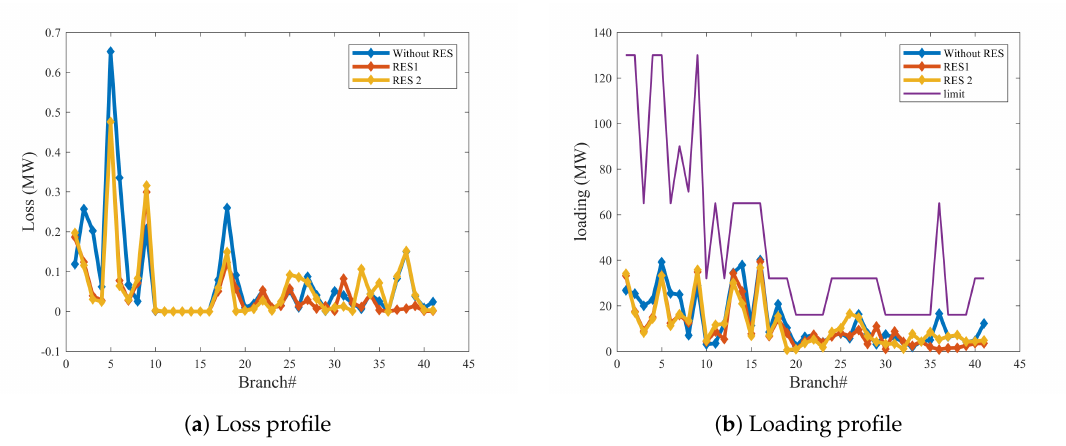
Figure 6. Loss and Loading Profiles for case 1 for IEEE 30-bus system, IEEE 30-bus Modified (1) and IEEE 30-bus Modified